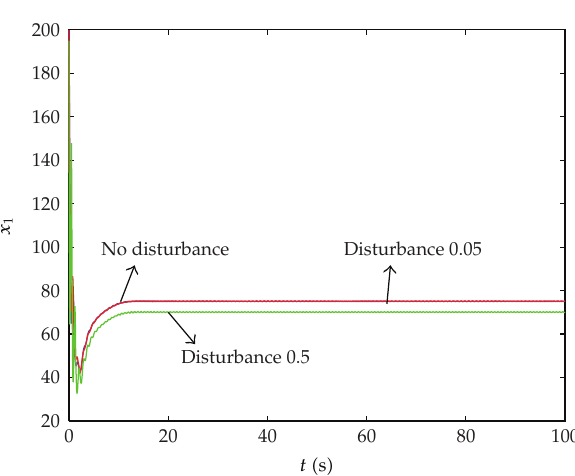
Figure 7: Trajectories of the state variable x 1 by T1ABFC with external disturbances.